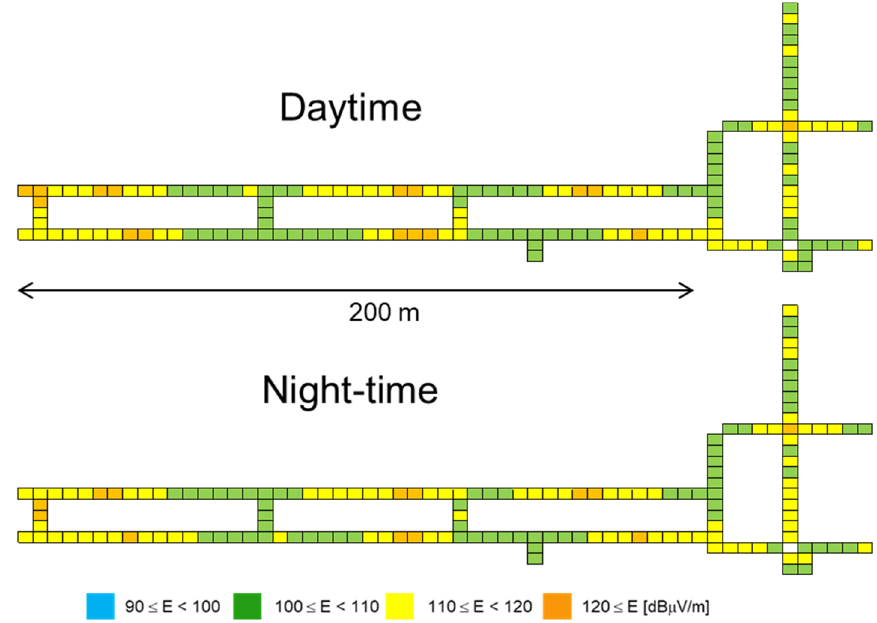
Figure 2. E-field strength in all frequency bands in the underground shopping mall.